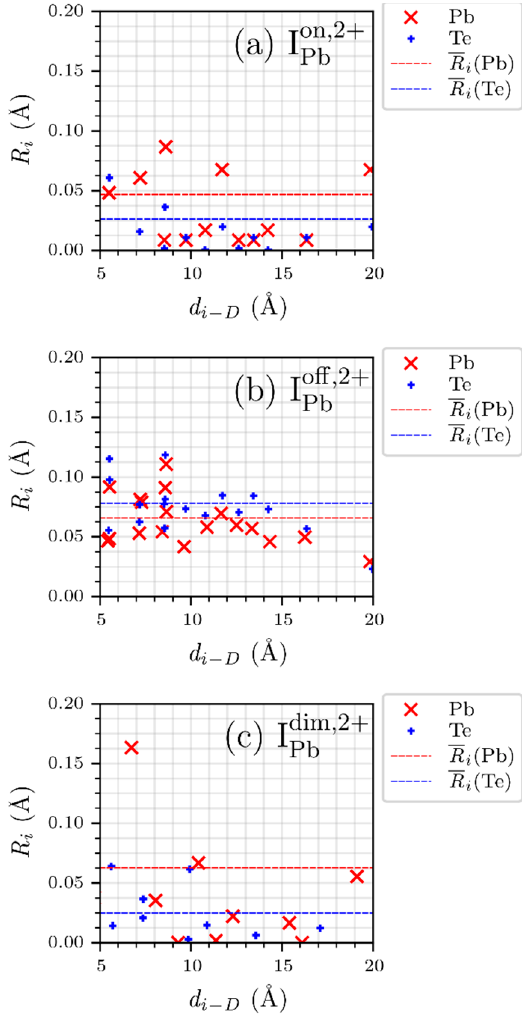
Figure 5. Structural relaxation parameters (R i ) of host atoms excluding the nearest neighbors of the Pb interstitial defect at the ( a ) on-centered (I on,2 + ), ( b ) off-centered (I off,2 + ), and ( c ) dimer (I dim,2 + ) Pb locations. Red “ × ” and blue “+” represent the data for Pb and Te atoms, and the red and blue dashed lines represent the average of R i for Pb and Te, respectively. The x-axis represents the defect distance parameter d i − D